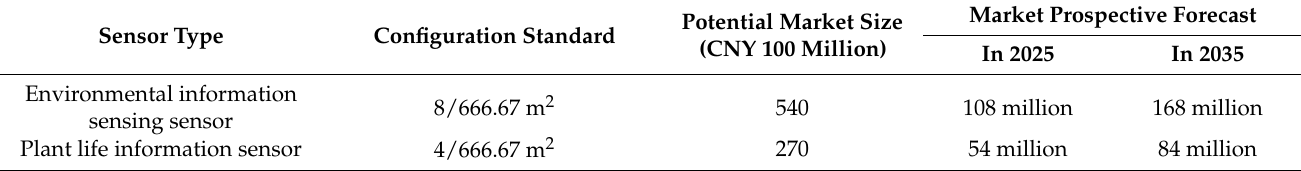
Figure 2. Changes in planting areas of facility agriculture in China from 2013 to 2019. Data source: China County Statistical Yearbook, National Bureau of Statistics. Table 6. Potential market scale and prospective forecast of sensors in the facility planting industry.